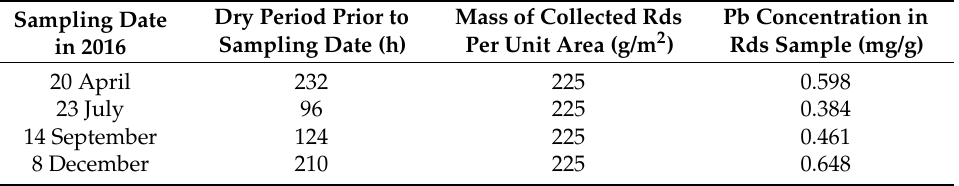
Table 2. Lead ion (Pb) Concentration in road-deposited sediment (RDS)